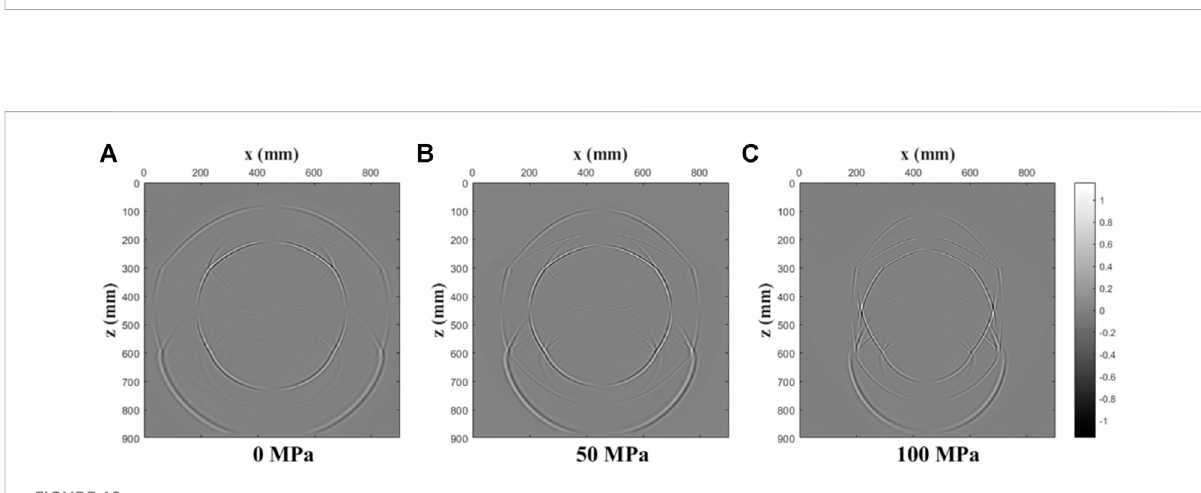
FIGURE 18 Coupled wave fi eld snapshots of the x -component at t = 0.1 ms for a three-layer model under various uniaxial stresses ( (A) : 0 MPa; (B) : 50 MPa; (C) : 100 MPa).